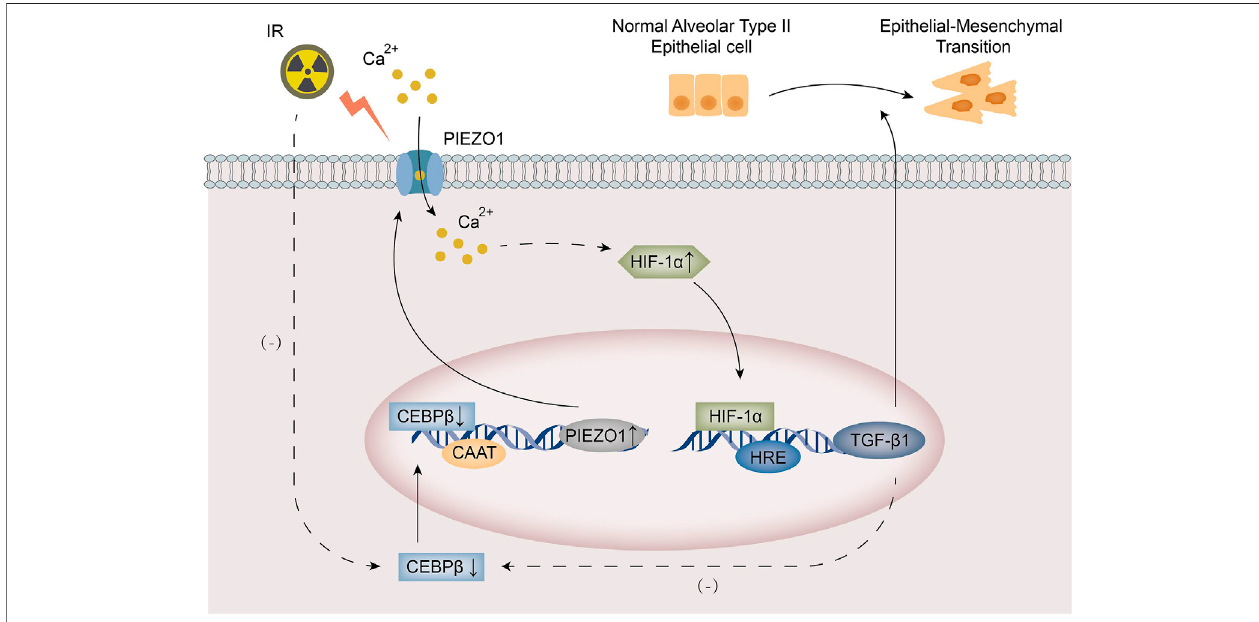
FIGURE 6 | A schematic diagram summarized the mechanism of PIEZO1/Ca 2+ signaling in radiation-induced epithelial-to-mesenchymal transition (EMT) by forming a positive feedback with TGF- β 1. Irradiation leads to increased PIEZO1 expression and decreased C/EBP β expression in rat alveolar type II epithelial (RLE-6TN) cells. Increased expression of PIEZO1 enhanced Ca 2+ in fl ux, which activates HIF-1 α to induce TGF- β 1expression and following EMT. C/EBP β expression was inhibited by exogenous TGF- β 1. C/EBP β binds to the promoter region of PIEZO1 to inhibit PIEZO1 expression. The PIEZO1/HIF-1 α /TGF- β 1/C/EBP β axis constitutes a positive feedback